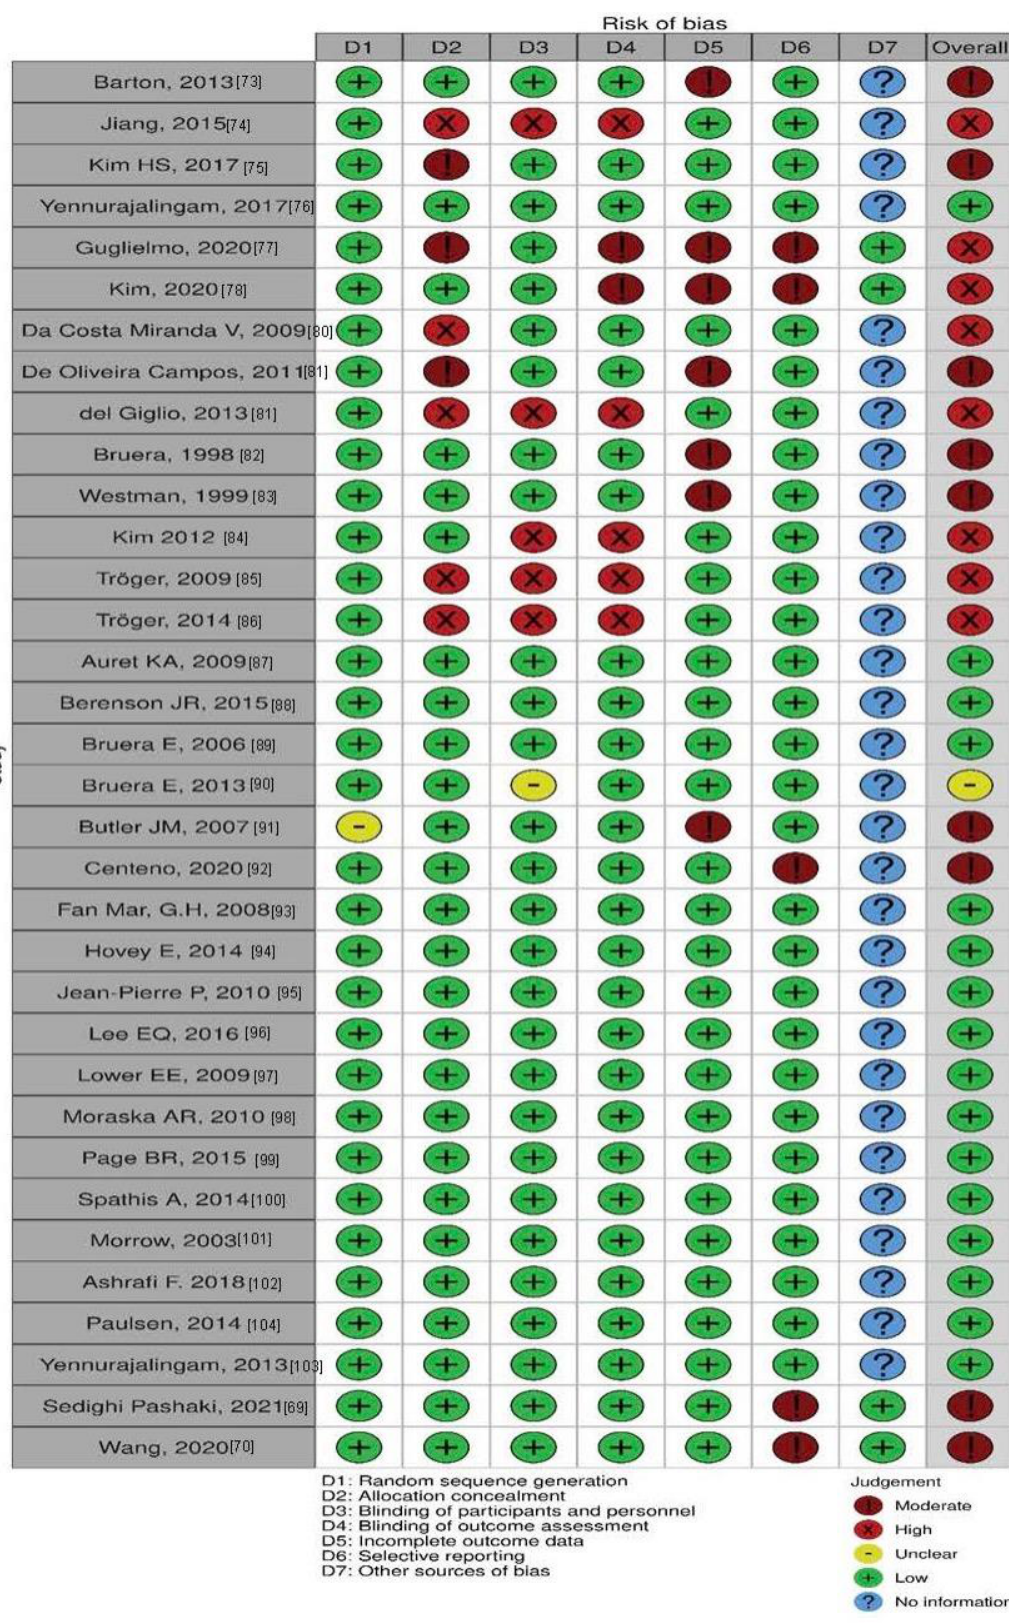
Figure 4. Cochrane risk of bias assessment using traffic-light plot.